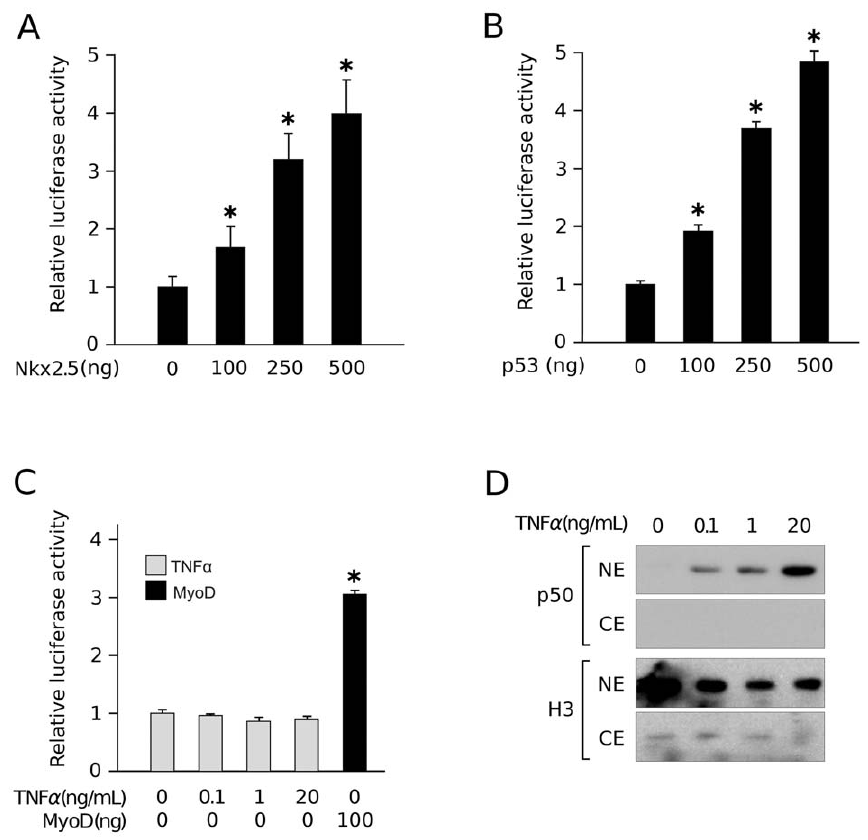
Figure 6. Transcriptional regulation of the Ankrd2 promoter by Nkx2.5, p53 and NFkB. Both Nkx2.5 (A) and p53 (B) are upstream effectors of Ankrd2 gene expression. C2C12 cells were transfected with Ankrd2 ( 2 439/ + 7)-LUC and Renilla luciferase reporter plasmids along with increasing amounts of expression vectors for Nkx2.5 and p53 as indicated. (C) Canonical NF k B does not affect Ankrd2 promoter activity. C2C12 were co- transfected with Ankrd2 ( 2 439/ + 7)-LUC and Renilla luciferase plasmids and 5 hrs after transfection cells were treated with increasing amounts of TNF a in order to activate NF k B. In all of these experiments the firefly luciferase activity was normalized against the Renilla luciferase. The histograms show the mean of at least three independent experiments; the bars indicate the standard deviation. *p , 0.05 versus control sample. (D) C2C12 cells were grown in the presence of 0.1, 1and 20 ng/ml of TNF a for 20 h and nuclear (NE) and cytoplasmic (CE) extracts prepared. Activation of NF k B by TNF a was confirmed by Western blot detection of NF k B subunit p50 in the nuclear extract (upper two panels). Efficiency of protein separation was monitored by histone H3 subcellular localization (lower two panels).